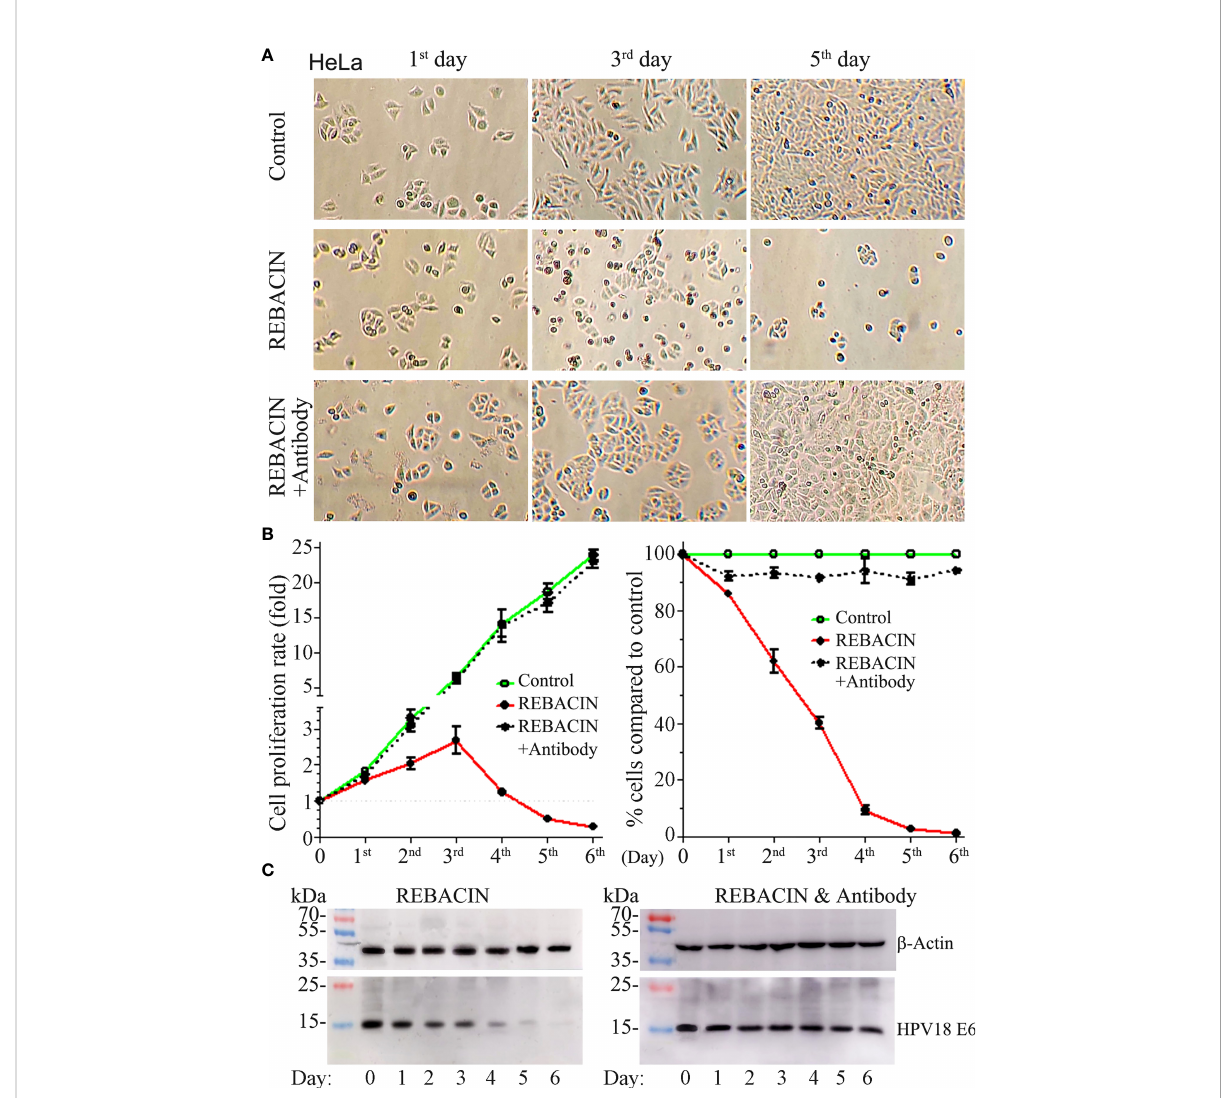
FIGURE 4 REBACIN ® inhibits HeLa cell ’ s growth via the suppression of HPV18 E6. HeLa cells in 24-well plate were treated or not treated by 50 m g/ml REBACIN ® or REBACIN ® /anti-REBACIN ® antibody for up to 6 days, and representative images in the 1 st , 3 rd , and 5 th day were shown in (A) . The total amount of alive cells in each well was counted every 24 hours, and their quantitative data show mean ± SEM of four independent experiments. REBACIN ® versus control: p < 0.05 in (B) . The expression level of b -actin and HPV18 E6 was detected by western-blot, and representative images were showed in (C)